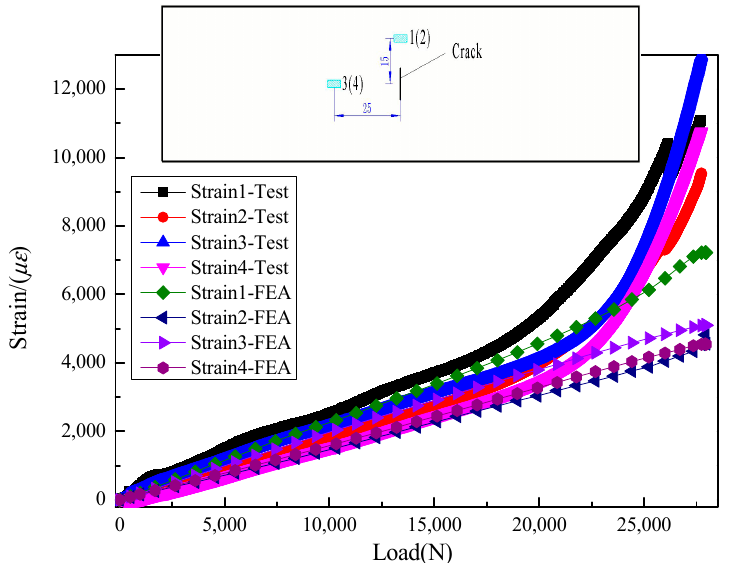
Figure 10. The comparison of strain-load curves obtained from FEM and experiments.